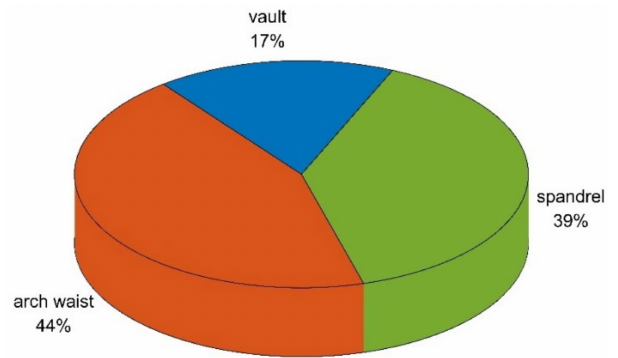
Figure 9. Statistics of rockburst locations.